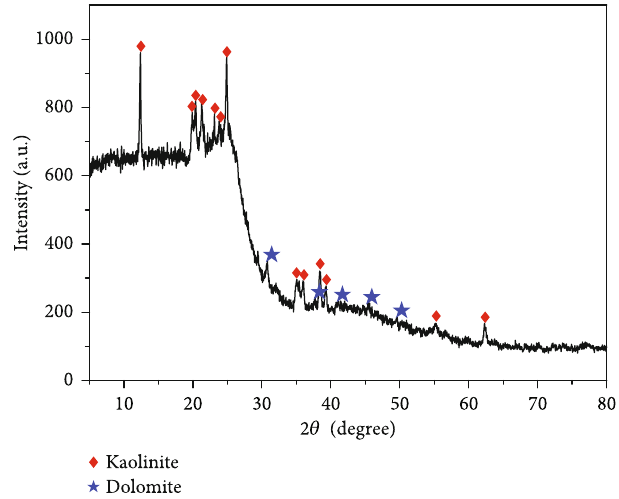
Figure 2: X-ray di ff raction pattern of mineral components in coal